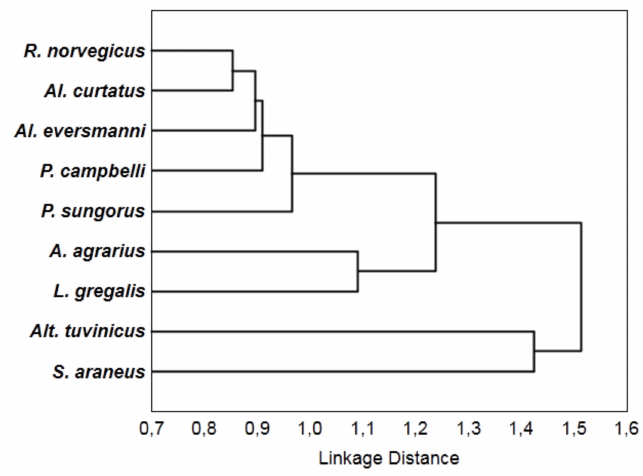
Figure 1. A dendrogram of similarity between hunting behaviors in the species studied based on the association coe ffi cients from Table